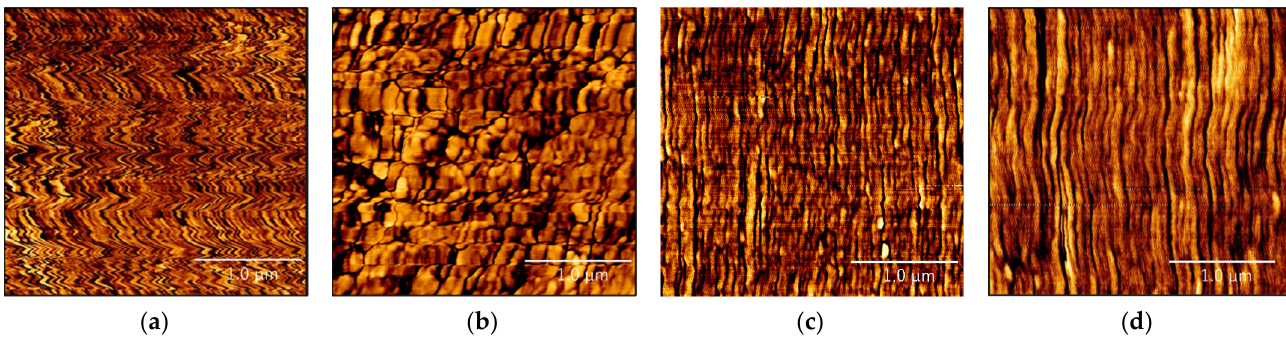
Figure 9. AFM phase images of the ( a ) original recycled polyethylene (RPE), ( b ) re-extruded RPE, ( c ) molten resin reservoir (MSR)-re-extruded RPE, and ( d ) virgin PE (VPE) pellet moldings. Scale bars indicate 1 µm.